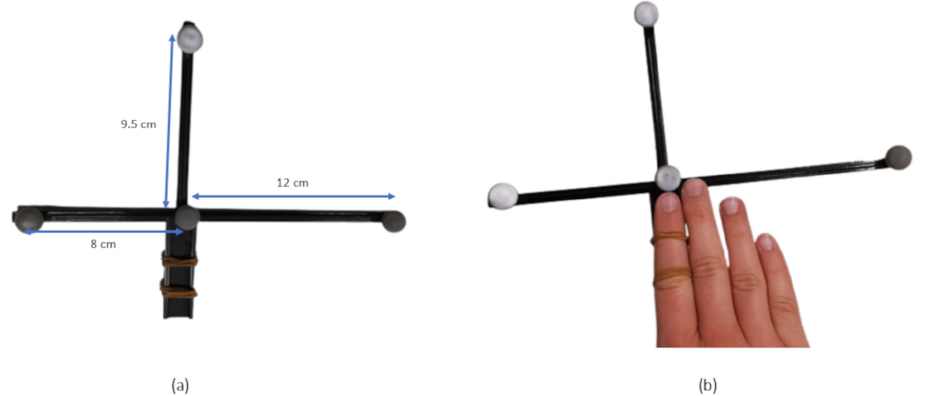
Figure 3. Rigid body used for tracking the user’s index finger: ( a ) Rigid body dimensions. ( b ) Rigid body on the user’s